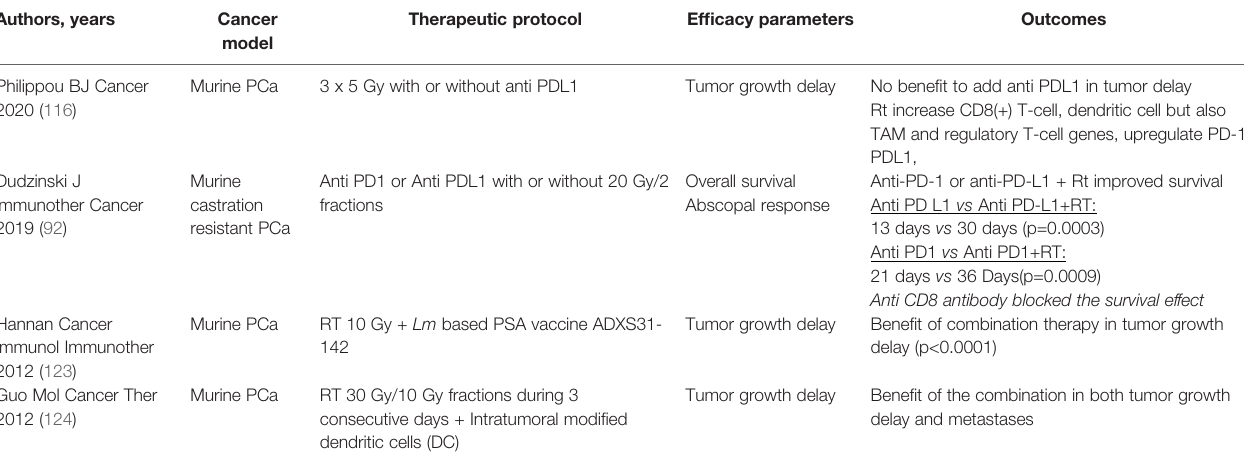
TABLE 1 | Radiotherapy and immunotherapy in mouse models of prostate cancer: Effect on tumor volume and survival. Authors,